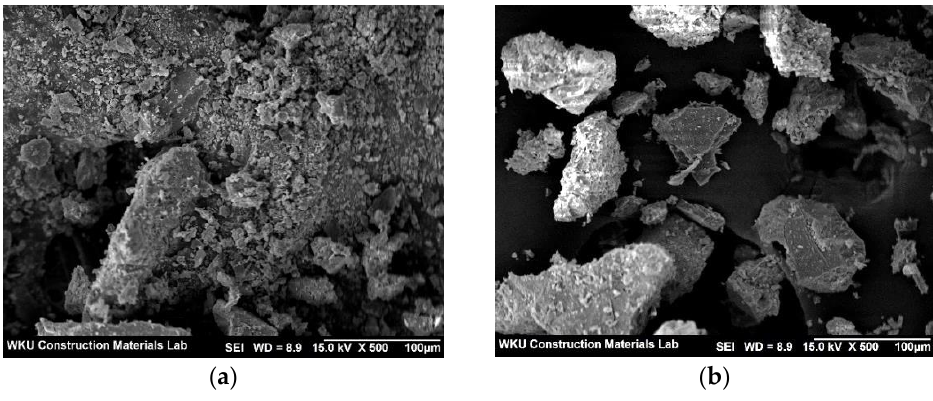
Figure 8. SEM images of the ( a ) control and ( b ) CPW7.5